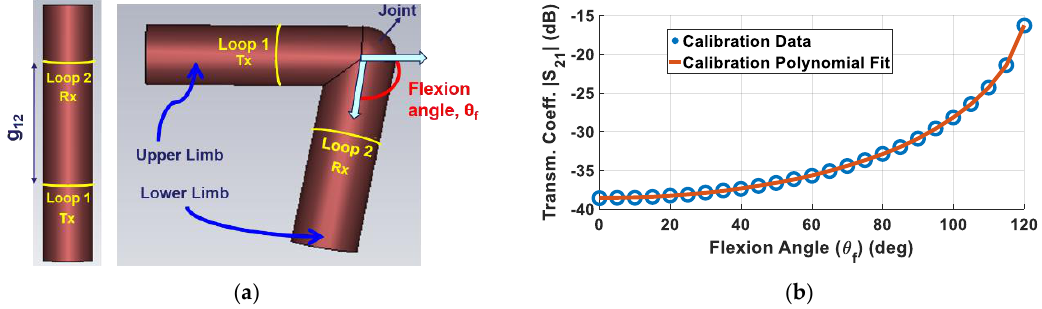
Figure 6. ( a ) Simulation setup for wearable loops to measure joint flexion angle [31]. This setup was